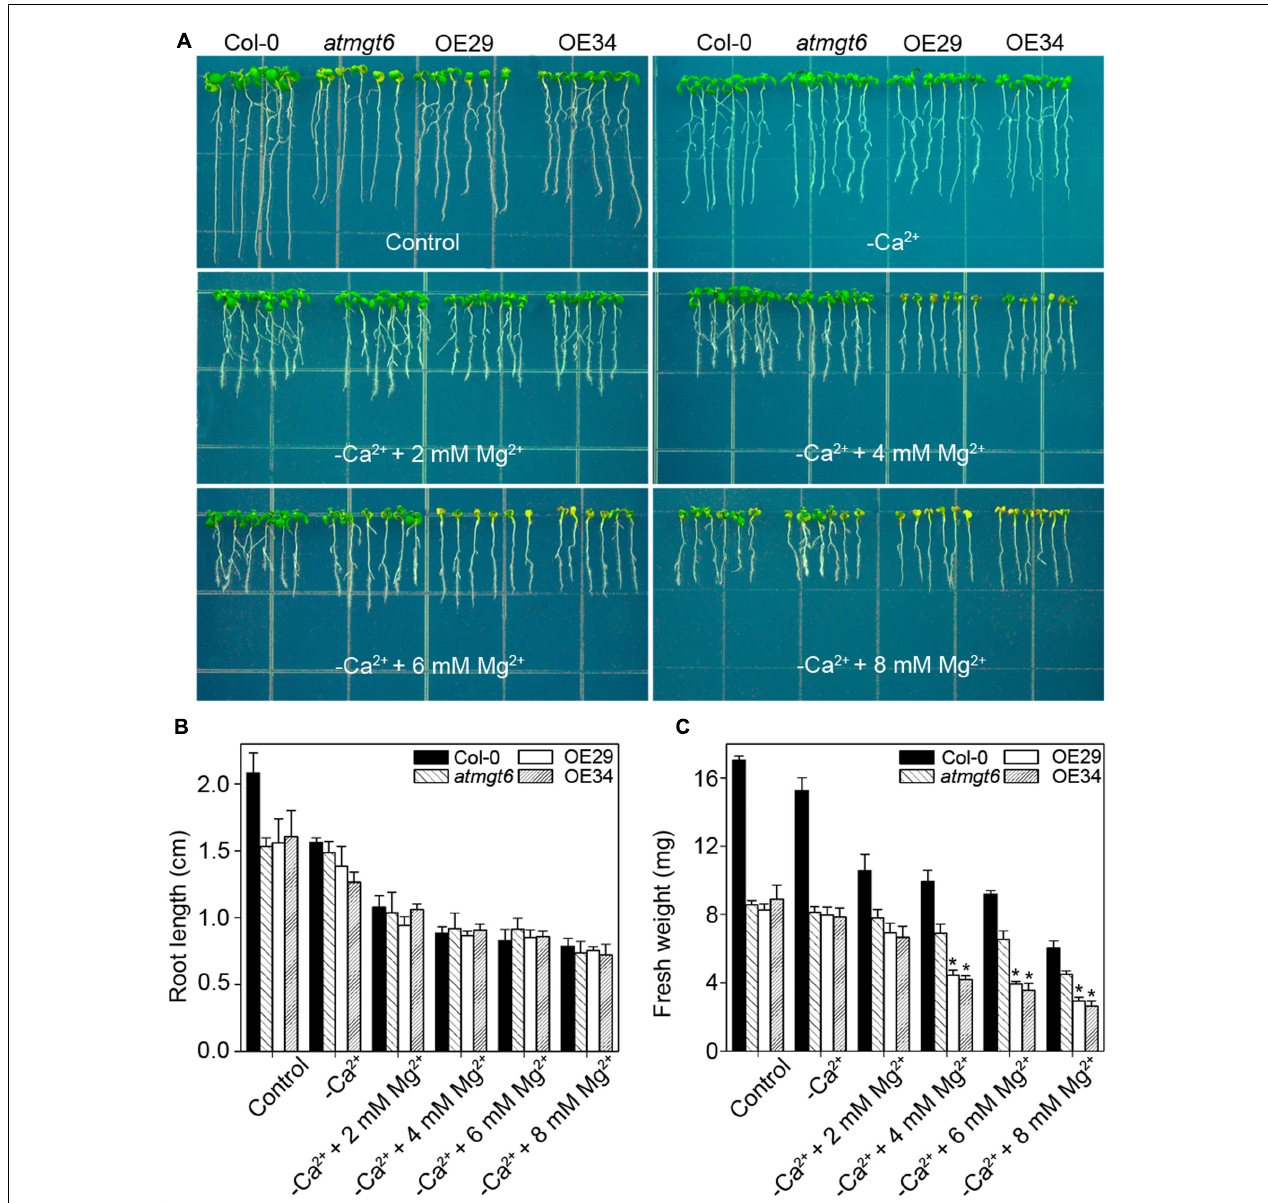
FIGURE 7 | Effects of the Ca 2 + depletion on the growth of atmgt6 and transgenic OsHKT2;4 -overexpression atmgt6 lines in the Mg 2 + -abundant medium. (A) The growth of Col-0, atmgt6 and transgenic two OsHKT2;4 overexpression atmgt6 lines (OE29 and OE34) in 1/6 MS (Control) and the 1/6 MS medium depleted of Ca 2 + (–Ca 2 + ). After planted in 1/2 MS medium for 3 days, Col-0, atmgt6 , OE29, and OE34 were transferred to the 1/6 MS medium (containing a basal 0.25 mM Mg 2 + and 0.5 mM Ca 2 + ), or the 1/6 MS medium depleted of Ca 2 + and supplemented with extra 2, 4, 6, or 8 mM Mg 2 + . Plants were photographed after growing for another 7 days. Quantitative analyses of primary root length (B) and whole-plant fresh weight (C) of Col-0, atmgt6 , OE29, and OE34 under the conditions described in (A) . Six independent 10-day-old seedlings of each genotype were gathered as one biological repeat for root length and fresh weight measurement. Data are represented as the mean ± SD, n = 3, in which n is the number of biological repeat. Asterisks indicate statistically significant differences compared with atmgt6 (Student’s t -test, ∗ P <